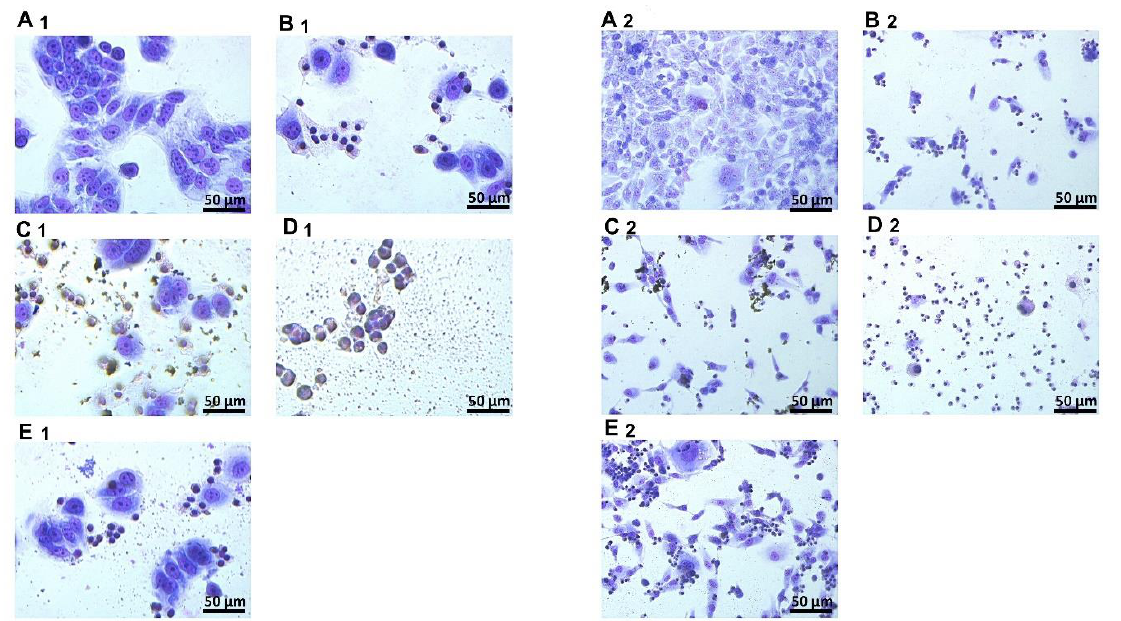
Figure 4. Morphology of MCF-7 and MDA-MB-231 cell lines after MGG staining. A—control group; B—group treated with MEL (10 mg / L); C—group treated with MEL-GN; D—group treated with MEL-GO; E—group treated with MEL-UDD; 1—MCF-7 cell line; 2—MDA-MB-231 cell line.